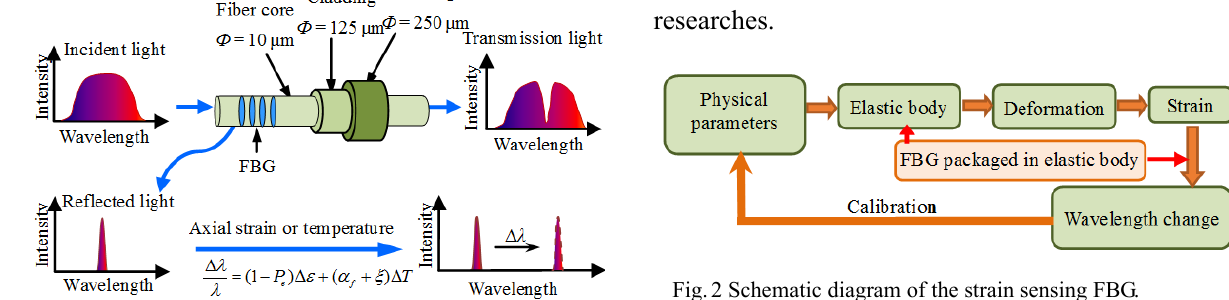
Fig. 1 Schematic diagram of the sensing principle of fiber Bragg grating.